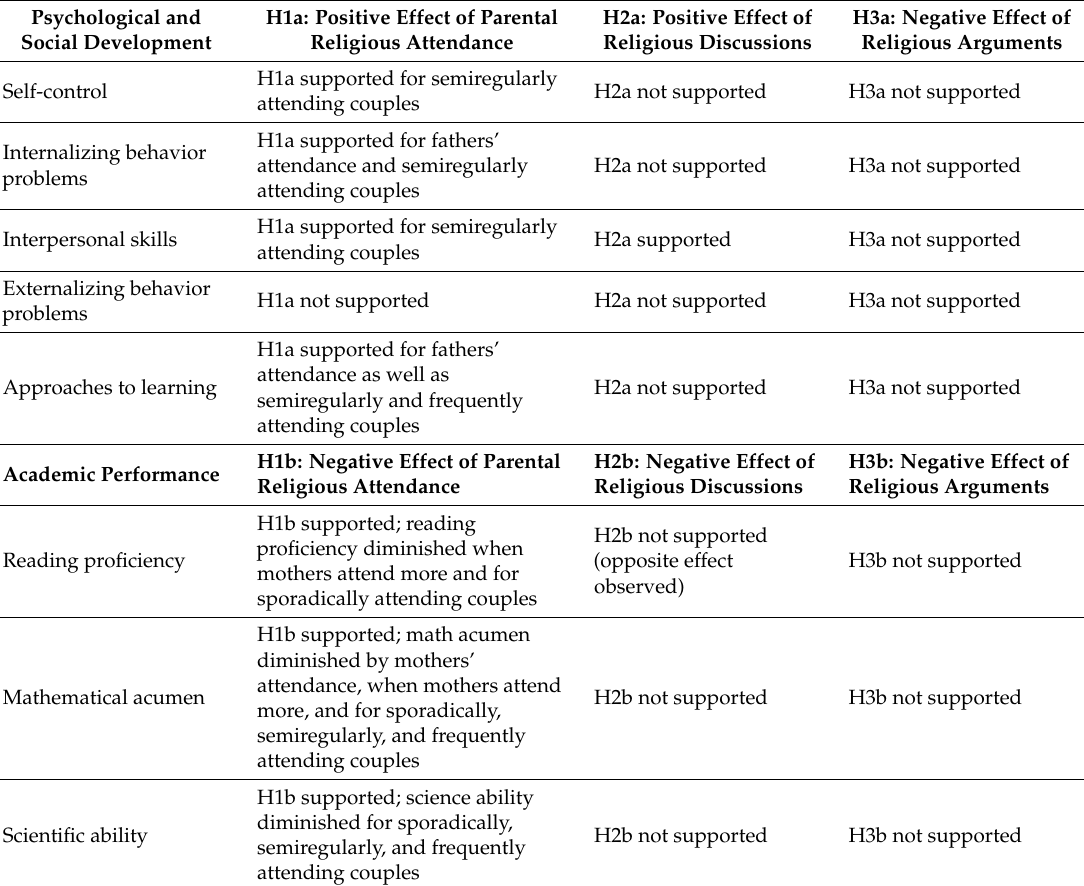
Table 10. Summary of Observed Results Relative to Hypothesized